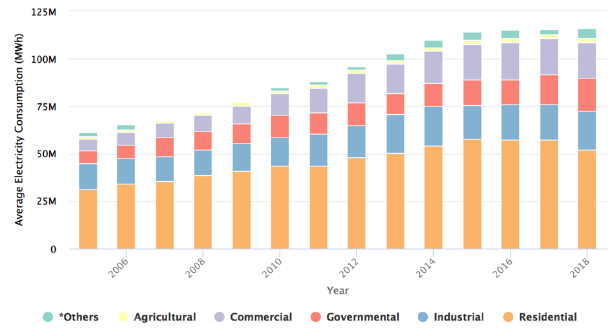
Figure 1: A sectoral energy consumption in KSA